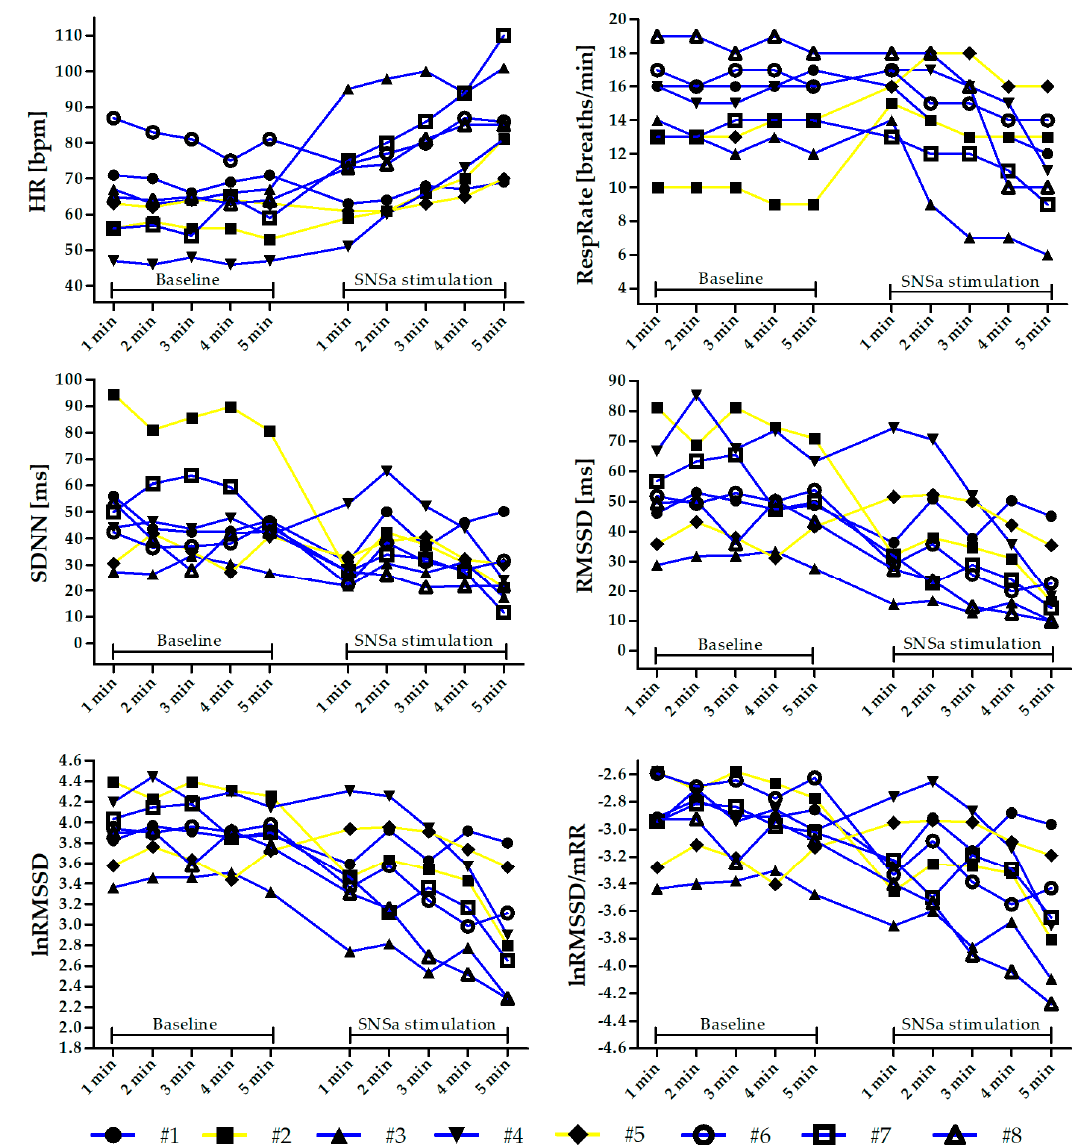
Figure 2. Individual changes in heart rate (HR), respiratory rate (RespRate), and heart rate variability (HRV) parameters minute by minute during the Baseline and sympathetic nervous system activity (SNSa) stimulation recordings. Individuals highlighted in yellow (#2 and #5) are those who increased the RespRate during SNSa stimulation.